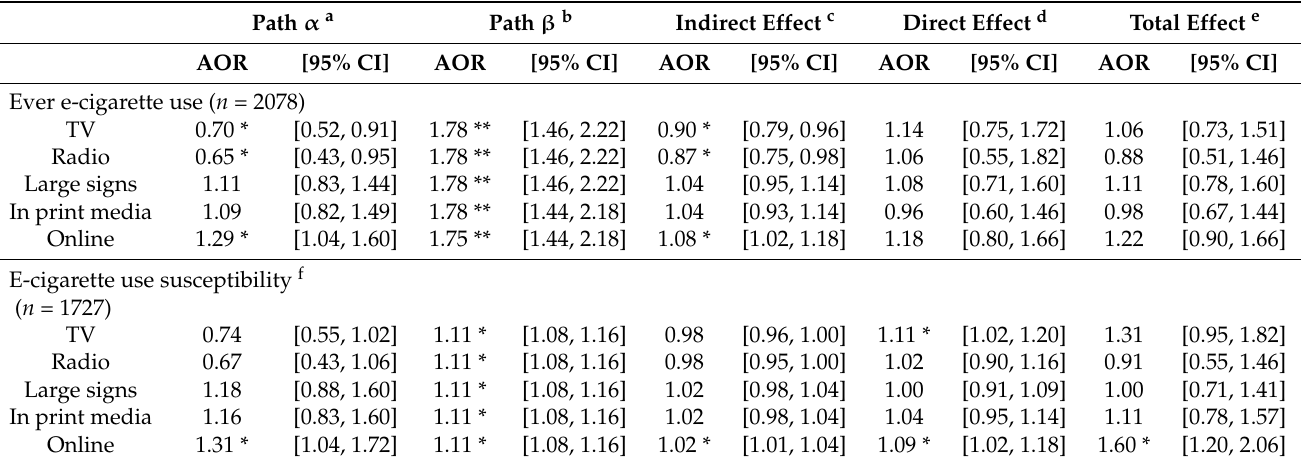
Table 2. Mediating role of e-cigarette harm perception in the relationship between e-cigarette adver- tising exposure and e-cigarette ever use and